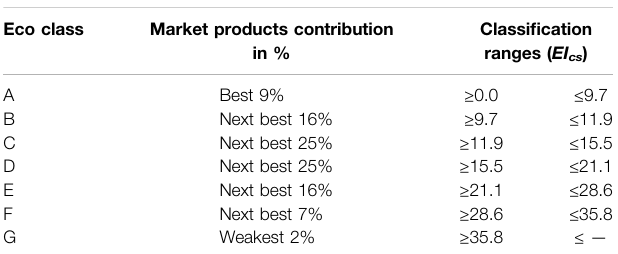
TABLE 4 | Eco class de fi